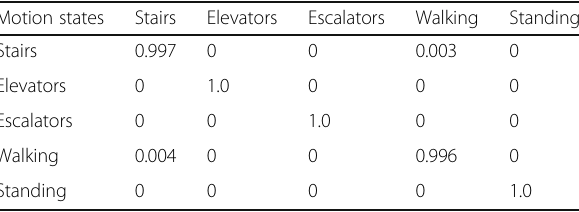
Table 1 Confusion matrix for landmark identification Motion